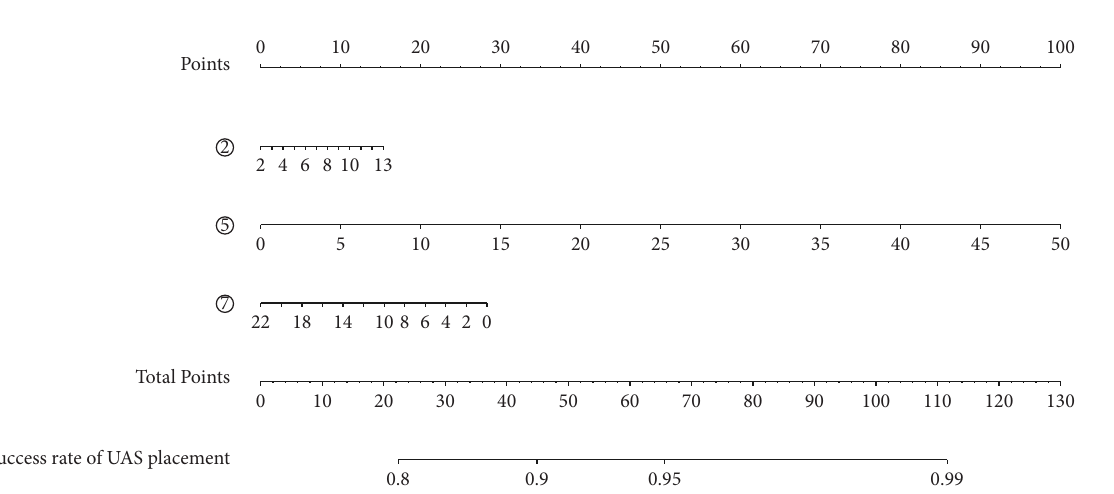
Figure 3: A nomogram predicting the probability of ureteral access sheath (UAS) placement. Instructions: locate the variable value on the corresponding axis. Draw a line straight upward to the point axis to determine how many points are towards the probability of UAS placement that the patient receives for his risk score value. Repeat the process for each addition variable. Sum the points for each of the predictors. Locate the fnal sum on the total point axis. Draw a line straight down to fnd the patient’s success rate of UAS placement.